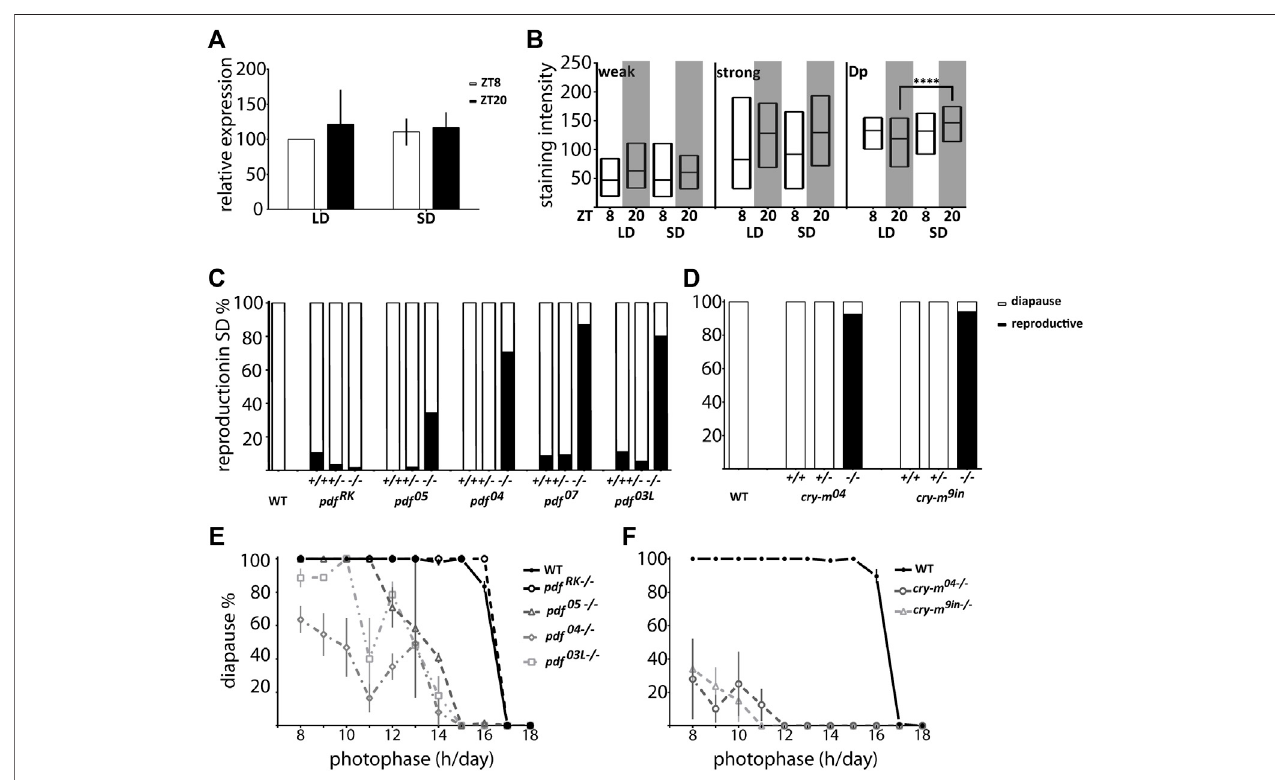
FIGURE 6 | Connection of P. apterus PDF and CRY-m to the photoperiodic response. (A) pdf expression in female heads during the day and night in LD and SD ( n = 3 independent repeats, error bar ± SEM). (B) PDF-immunostaining intensity in weakly (weak) and strongly (strong) stained cells and dorsal protocerebrum arborizations (Dp) in female brains during the day and night in LD and SD ( n = 12 – 16, Kruskal-Wallis test: weak p > 0.05, strong p > 0.05, Dp p < 0.05 and Dunn ’ s post hoc p < 0.0001)Floatingbars represent mintomax valueswith thelineat mean. Statistical difference ismarkedby(****) p < 0.0001. (C) Reproductivestatus ofWT and pdf +/+ , +/ − and − / − in SD conditions. (D) Reproductive status of WT and cry-m +/+ , +/ − and − / − in SD conditions. (E) The photoperiodic curve of WT and pdf homozygous mutants (F) The photoperiodic curve of WT and cry-m homozygous mutants Data presented as mean values with error bars ± SEM.